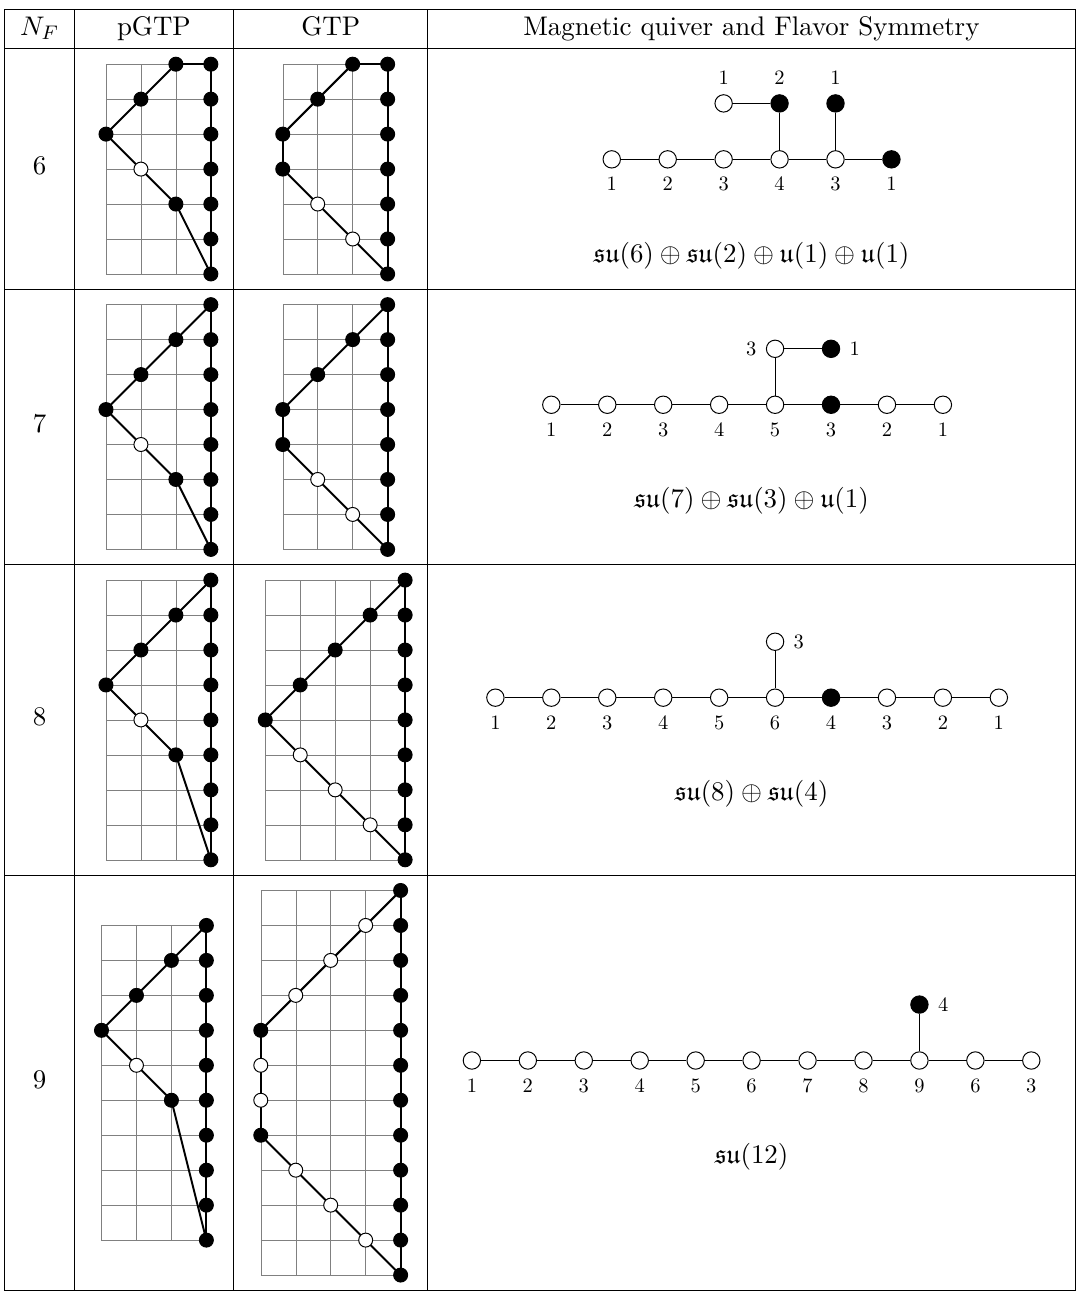
Table 6 . pGTPs, GTPs, MQs and flavor symmetries for SU(4) k + 1 AS + N F F for N F = 6 , 7 , 8 , 9 and k = 0 or k = 1 2